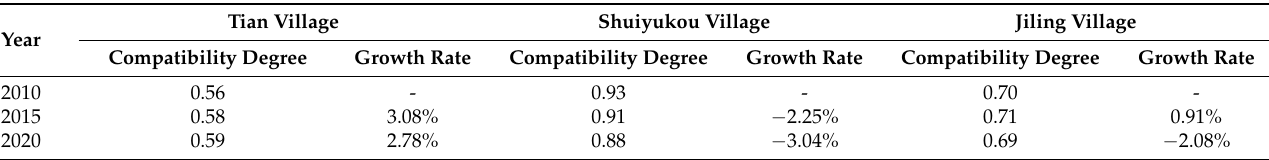
Table 7. The compatibility degree between production land and living land in rural